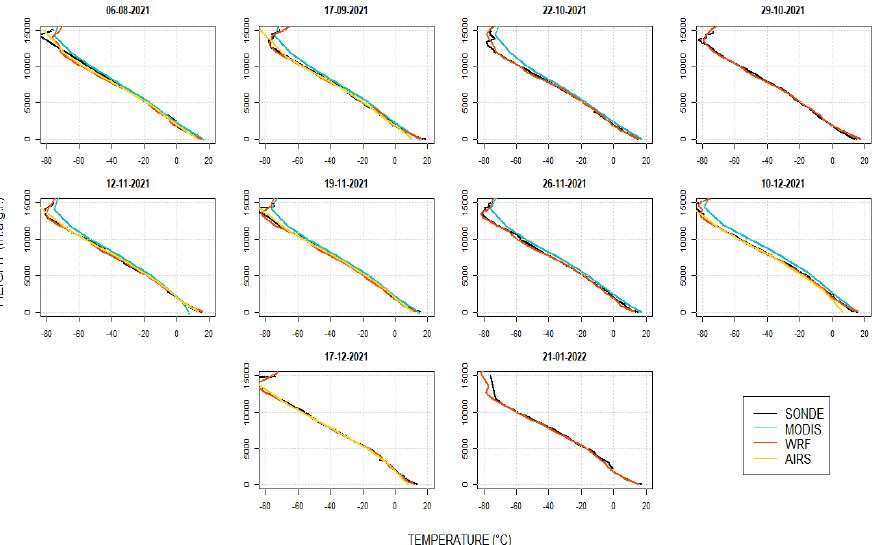
Figure 6. Temperature profiles measured with radiosonde (black), MODIS (sky-blue), AIRS (yellow), and WRF (orange) up to 15,000 magl. for 10 measurement events.